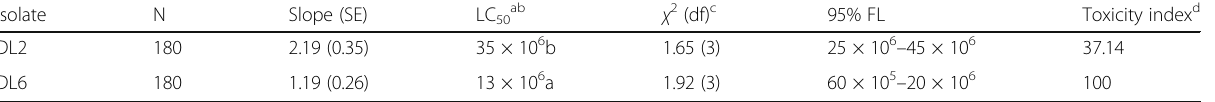
Table 3 Toxicity values of DL2 and DL6 isolates to 4th instar nymphs of Schistocerca gregaria using leaf dipping bioassay technique Isolate